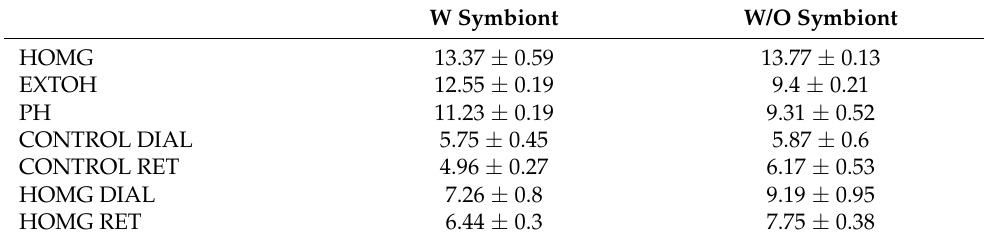
Table 2. Total polyphenols content of different samples obtained from Anemonia sulcata